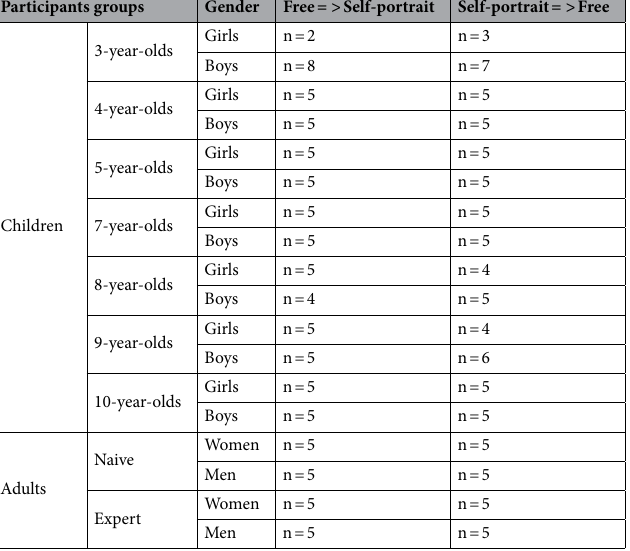
Table 1. Groups, sex and test condition of human participants. For each group of participants, half of the subjects began testing with the free condition instructions; the other half with the self-portrait condition. The choice was made randomly.